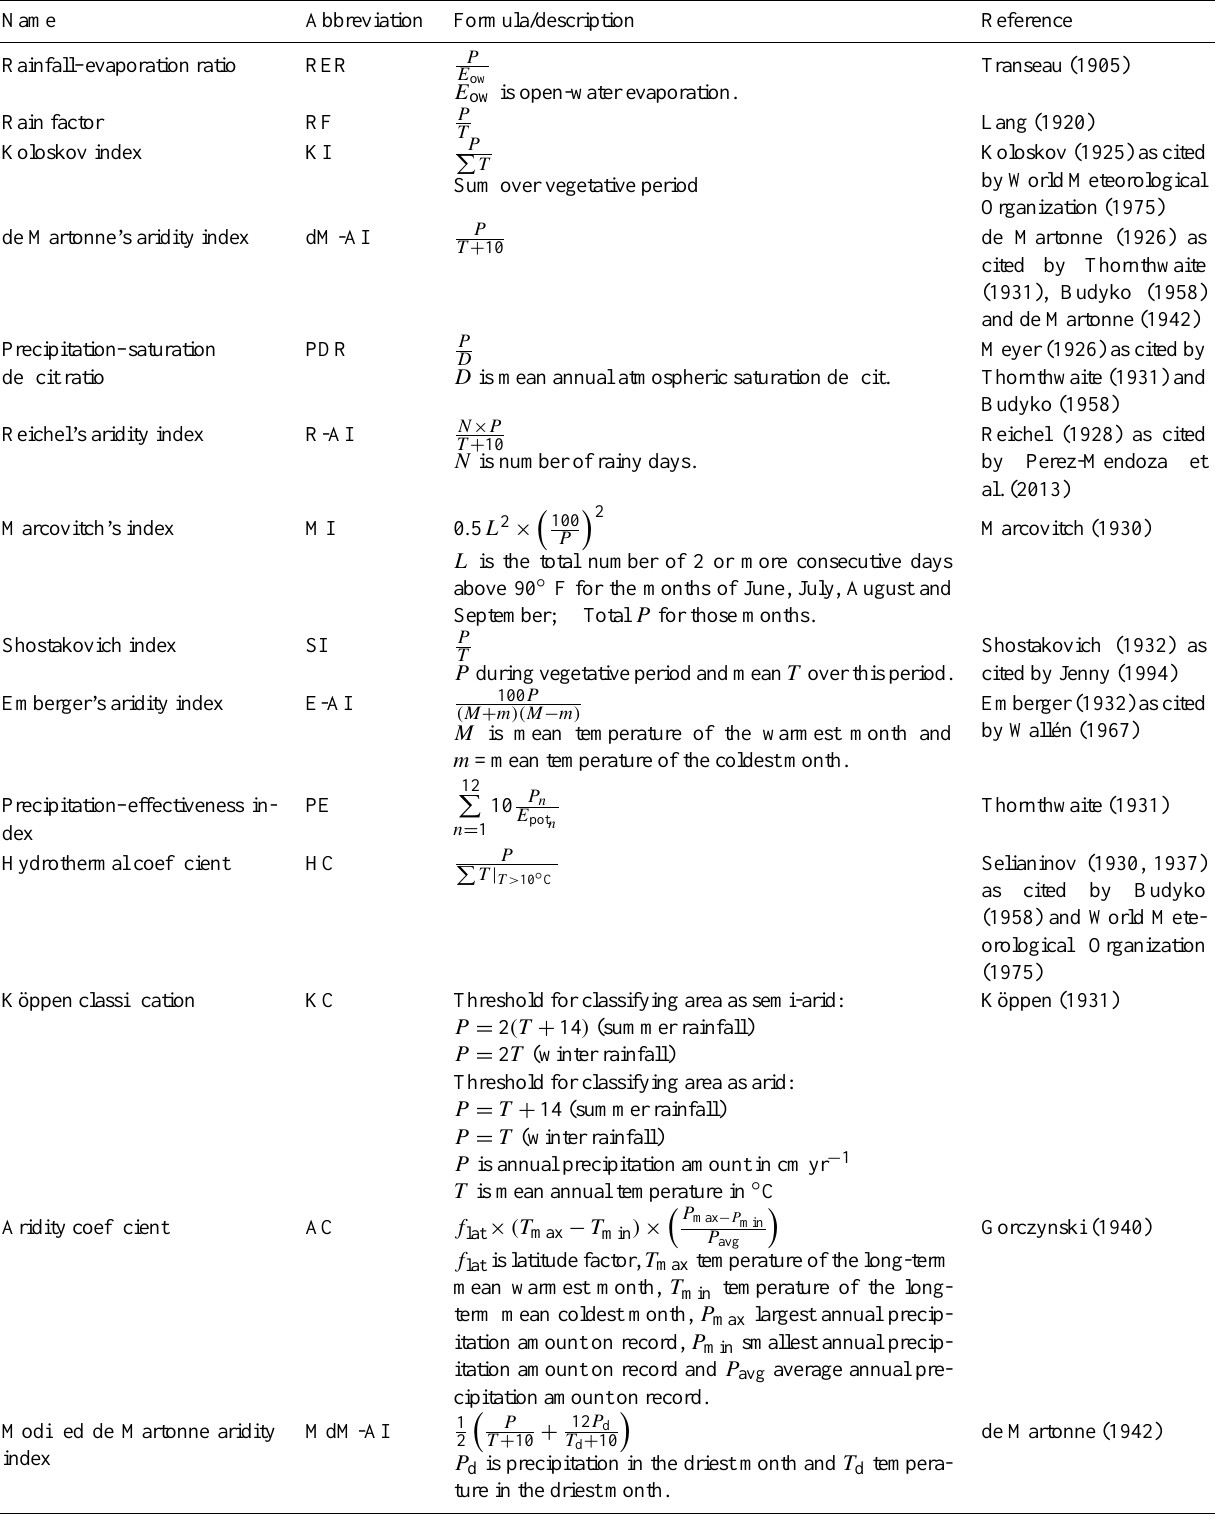
Table A1. Aridity